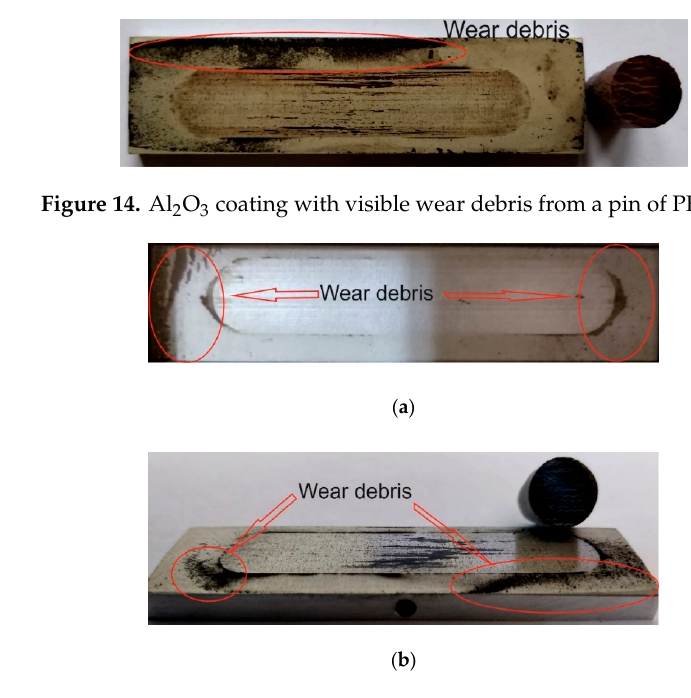
Figure 15. Samples with visible wear debris from a: ( a ) pin of PF + jute with visible bright wear debris on Al 2 O 3 / IF-WS 2 and ( b ) pin of PF + cotton + C on Al 2 O 3 / IF-WS 2 . In Figure 16a–d the SEM micrographs of pins of PF composites are shown. The cotton fibers were visible in Figure 16a,c,d, and jute fibers in Figure 16b.